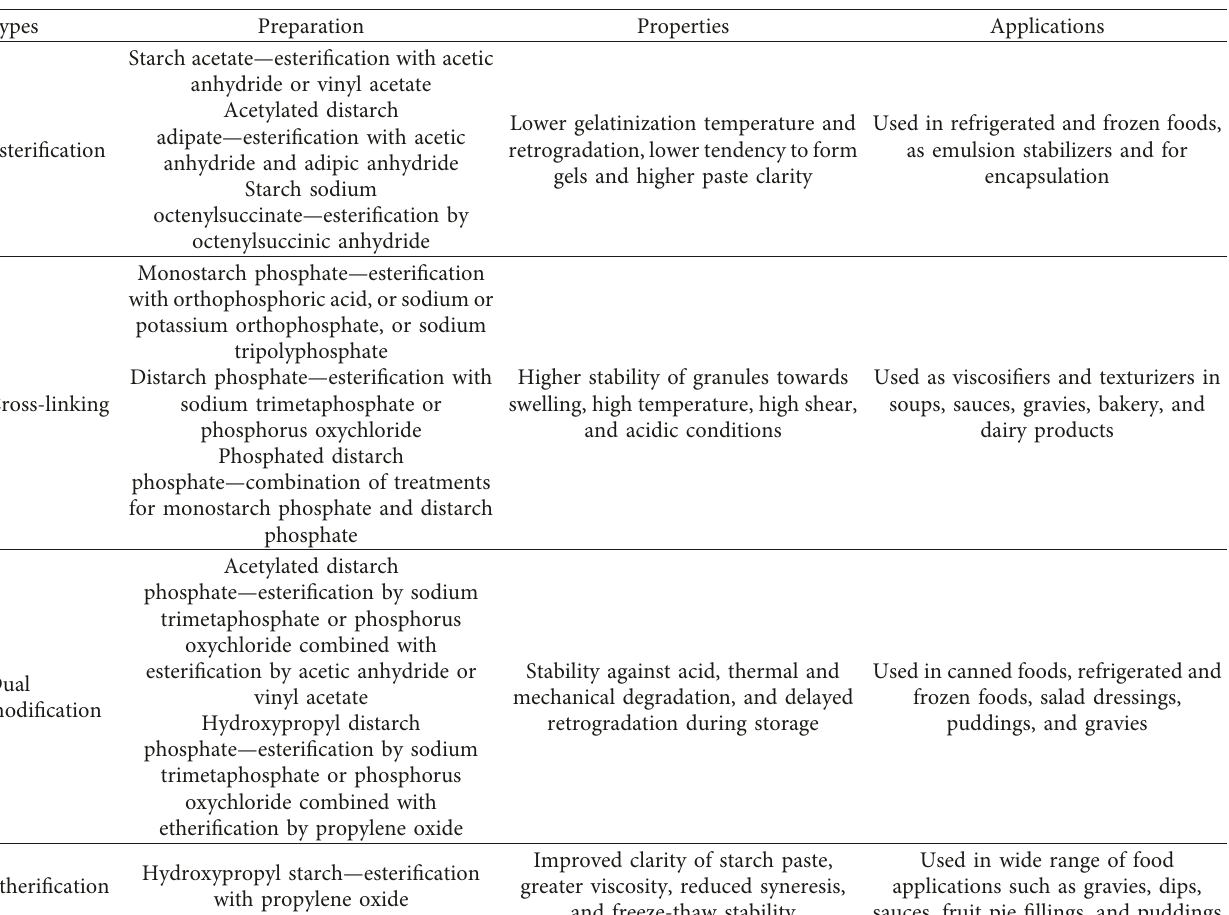
Table 1: Preparation techniques of different starch esters and their properties with